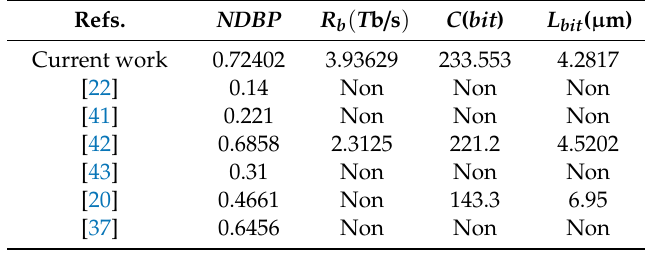
Table 3. Comparison between current work and previous literature.